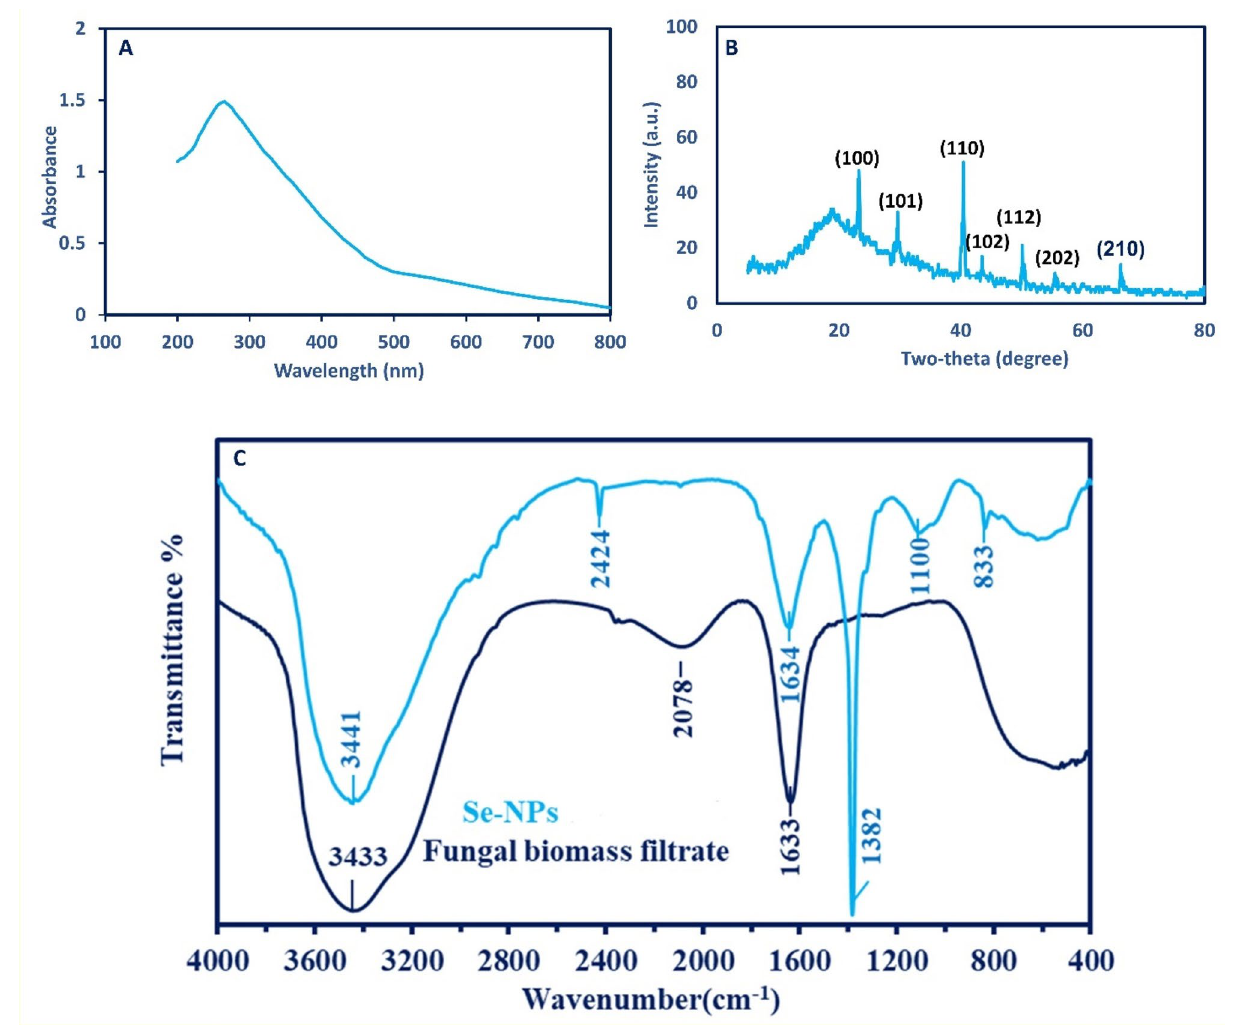
Figure 1. ( A ) UV–Vis spectroscopy that showed the maximum SPR at 270 nm; ( B ) XRD analysis shows the crystallinity nature of green synthesized Se-NPs; and ( C ) FT-IR chart that refer to the various functional groups in fungal biomass filtrate and synthesized